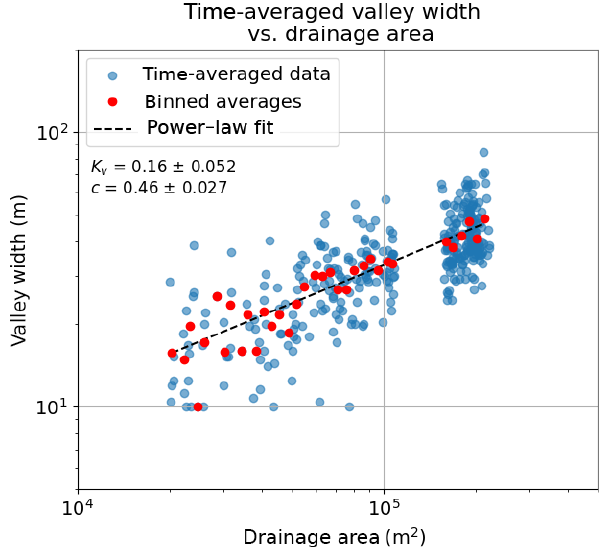
Figure 14. Valley width vs. drainage area for six time slices in the undercutting-slump increased water flux model with d x = 10, K = 10 − 4 , and α = 0 . 8. All six time slices are from the model at steady state, with three time slices taken from the period of normal water flux and three time slices taken from the period of increased water flux. Each time slice represents data averaged over 2500 years of model time, or 1.6% of the total length of the model run. The red dots show log-binned averages of valley width. The black line shows a least squares power-law fit for the binned data. The K v co- efficient has a value of 0.16 with a standard error of 0.052 and the c exponent has a value of 0.46 with a standard error of